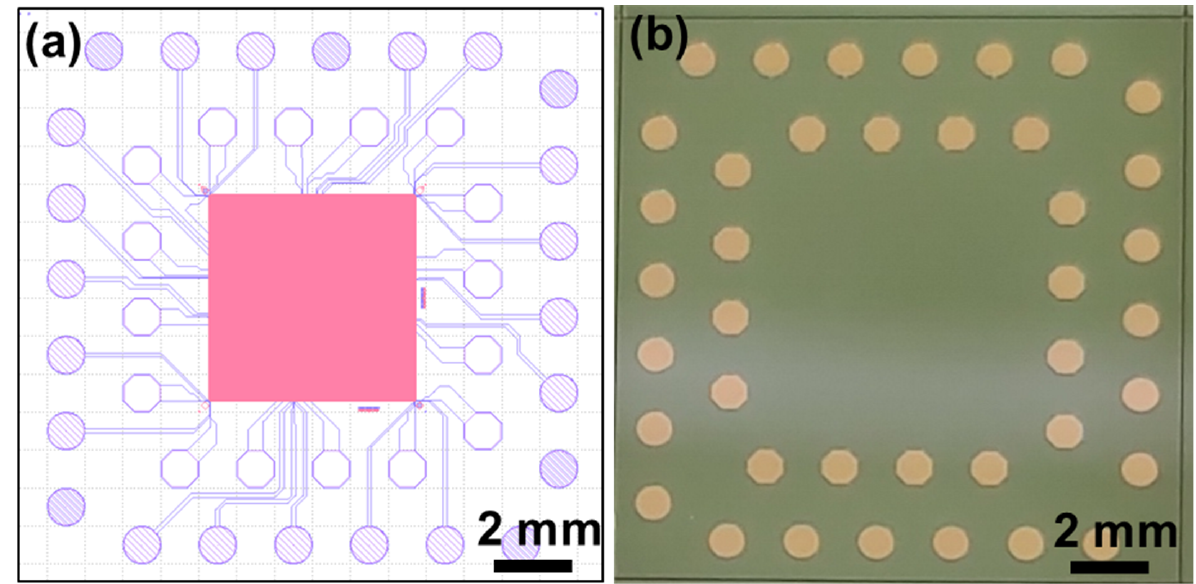
Figure 2. ( a ) Layout design for the test vehicles with top die bonded to bottom die. ( b ) Photo of a diced die.